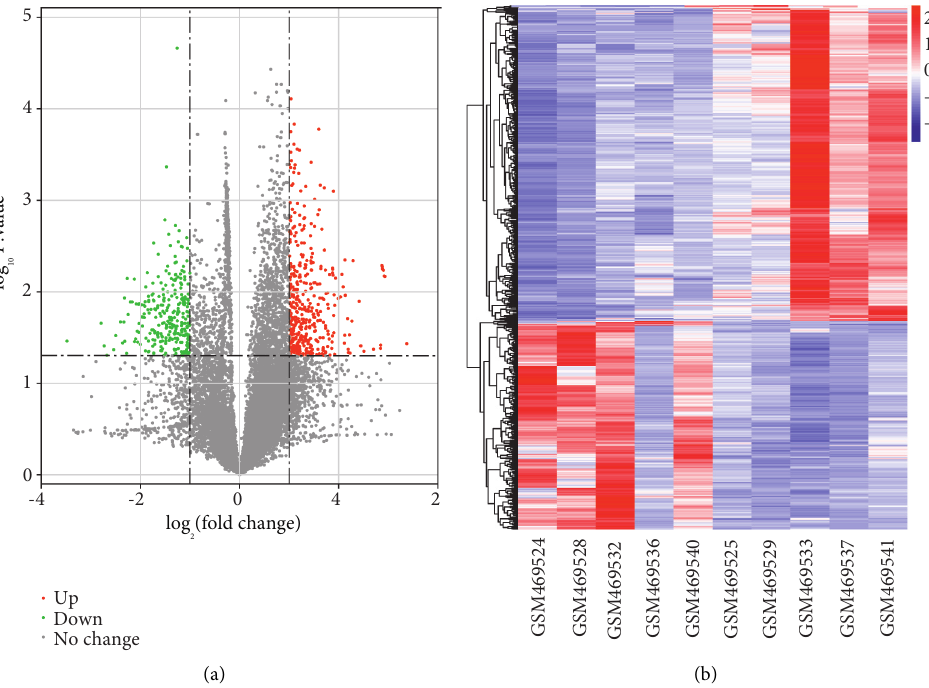
Figure 1: Volcano plot and heat map of DEGs. (a) Volcano plot. Green represents downregulation of DEGs, red represents upregulation of DEGs, and gray represents no significant change genes. (b) Heat map of the distribution of all DEGs in the two sets of